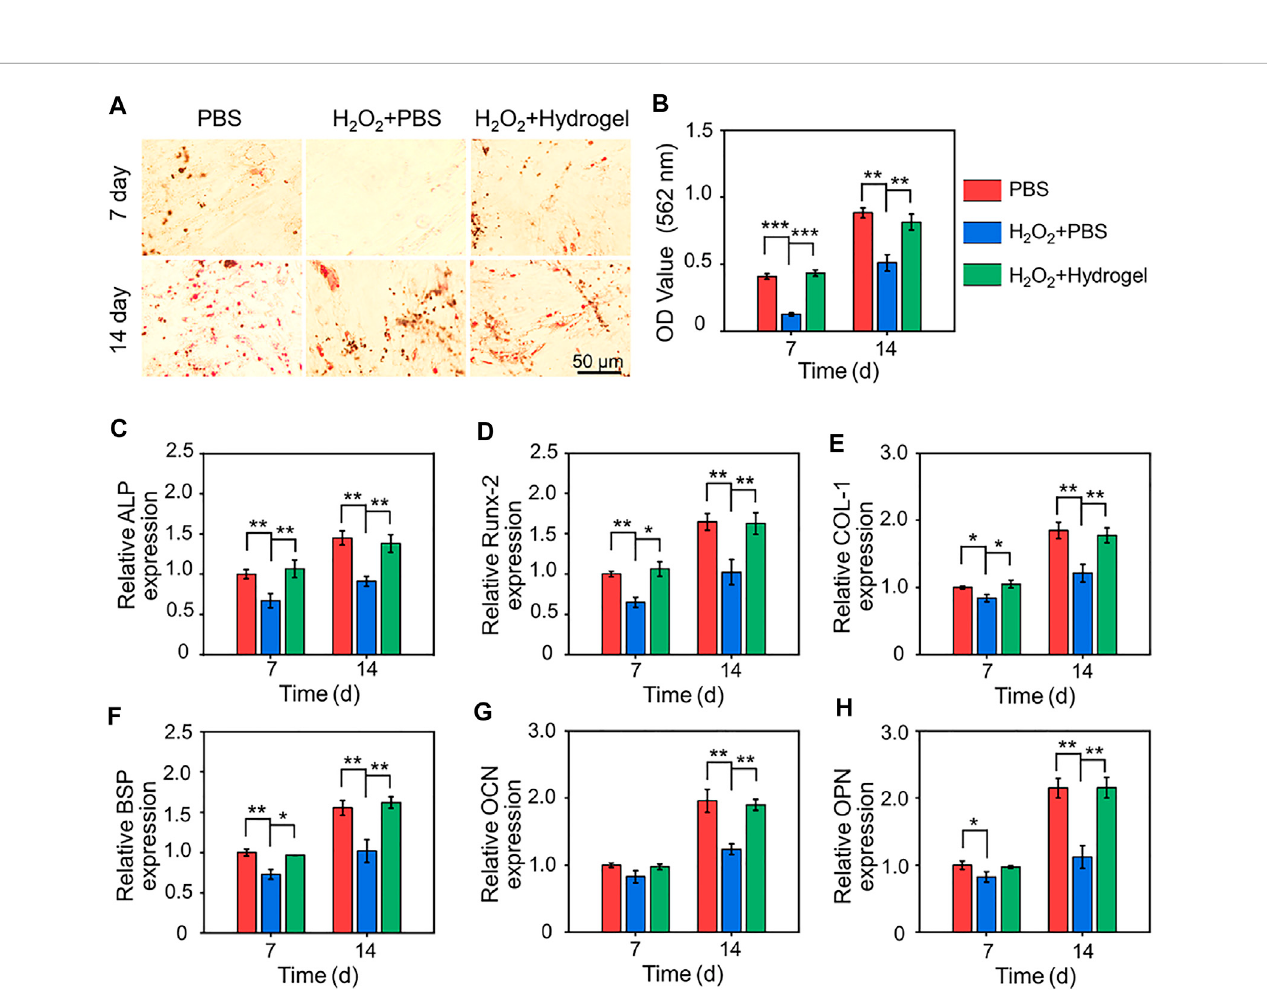
FIGURE 5 (A) Gross images of alizarin red staining after 7 and 14 days of cell culture. (B) Semi-quantitative analysis of the deposition of calcium nodules by alizarin red staining. (C – H) Expression of osteogenesis-related genes in different groups (* p < .05, ** p < .01, and *** p <